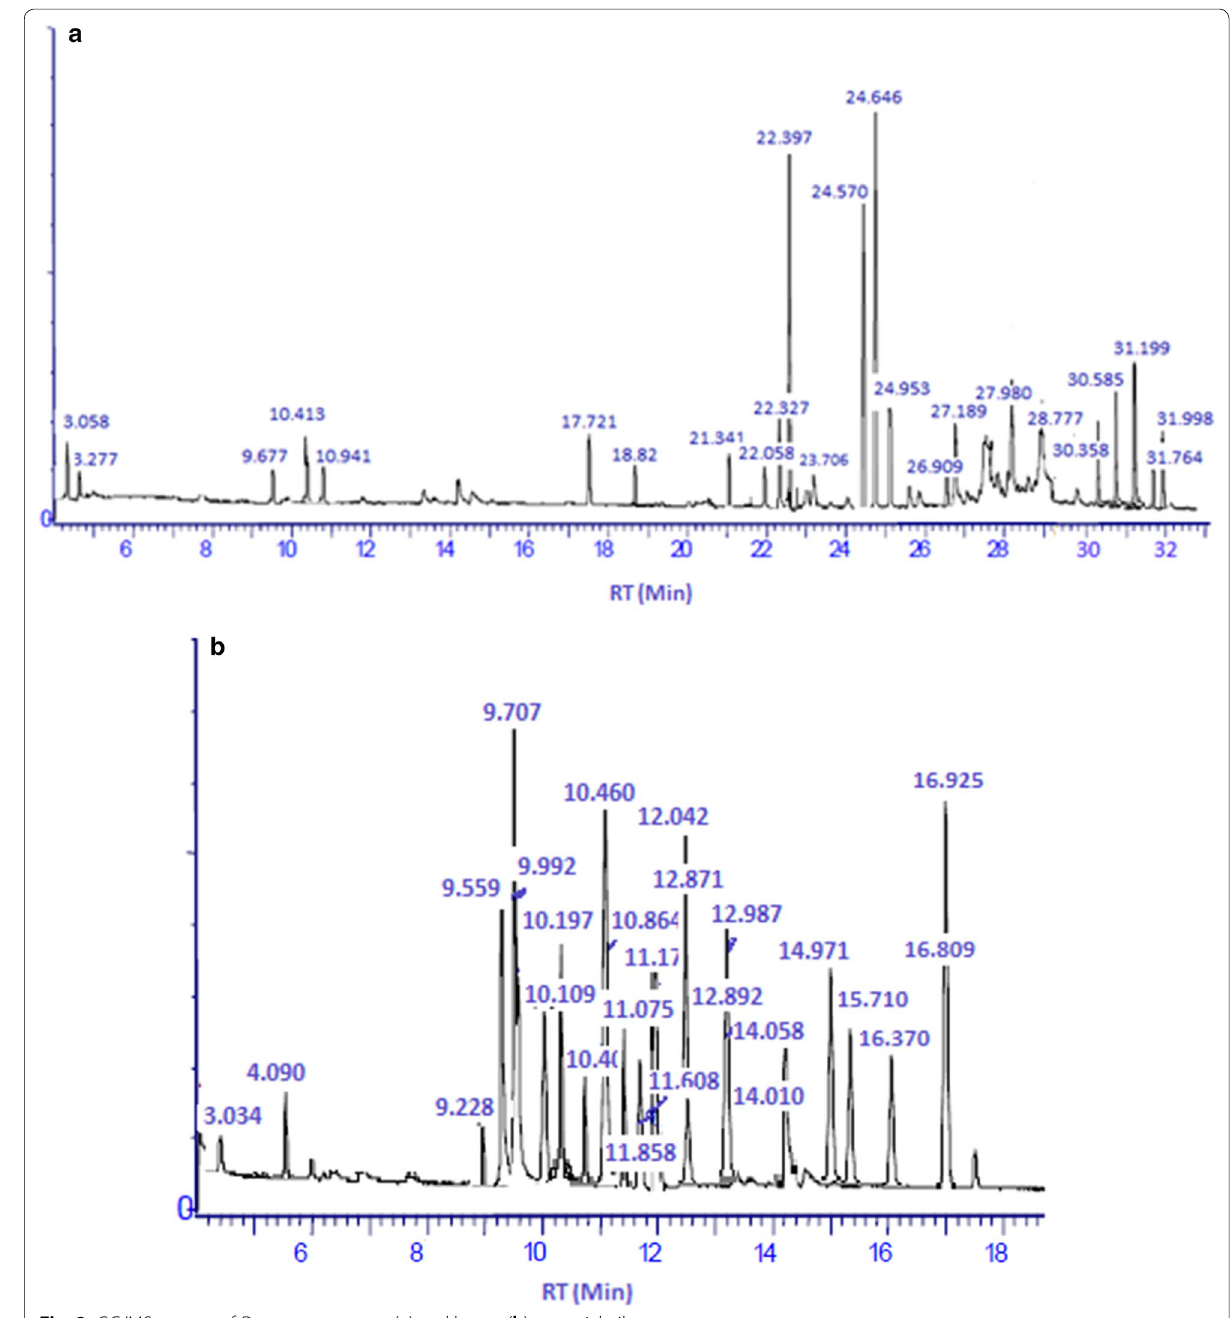
Fig. 2 GC/MS spectra of D. mucronata stem ( a ) and leaves ( b ) essential